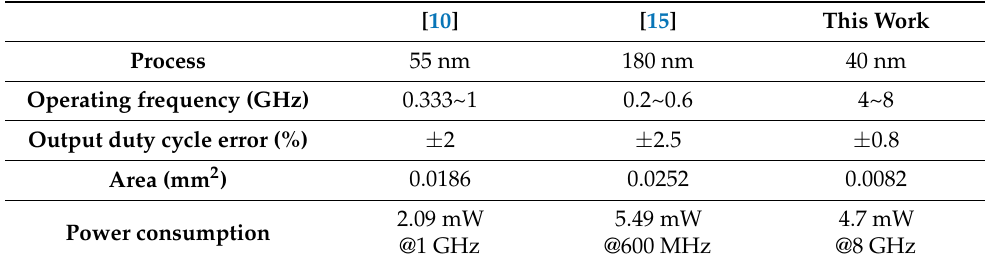
Table 1. Performance